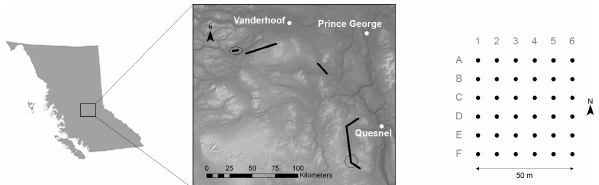
Fig. 1. Study area location within British Columbia (left) including ALS transects (black straight lines in the close-up) and ground plot locations in the Vanderhoof (top left corner ellipse) and Baker Creek (bottom right corner circle) areas; the 2500m 2 square ground plots (right) are constituted by 36 individual stakes (spaced 10m) labelled as letter and number combinations (A1 to F6) (Teti,